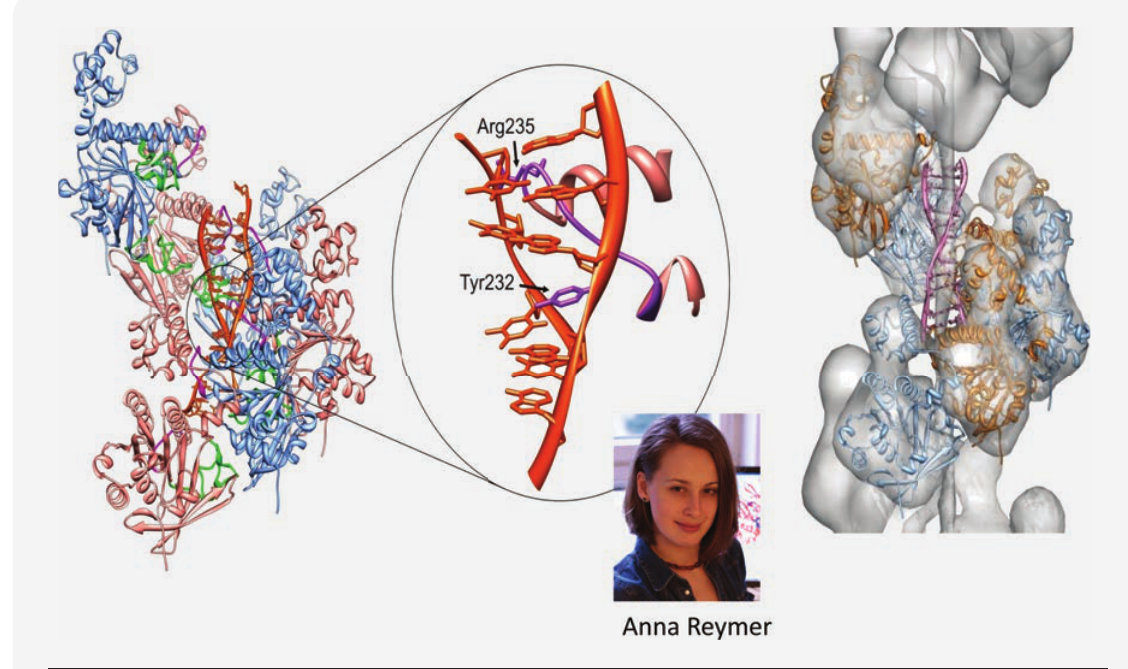
Figure 8. Structure of human Rad51-DNA complex determined from Site Specifi c Linear Dichroism by Molecular Replacement (SSLD-MR) spec- troscopy and molecular modeling 31 . To the right an electron density map from electron microscopy showing agreement of contours with model. Figure adapted from results kindly provided by Dr Anna